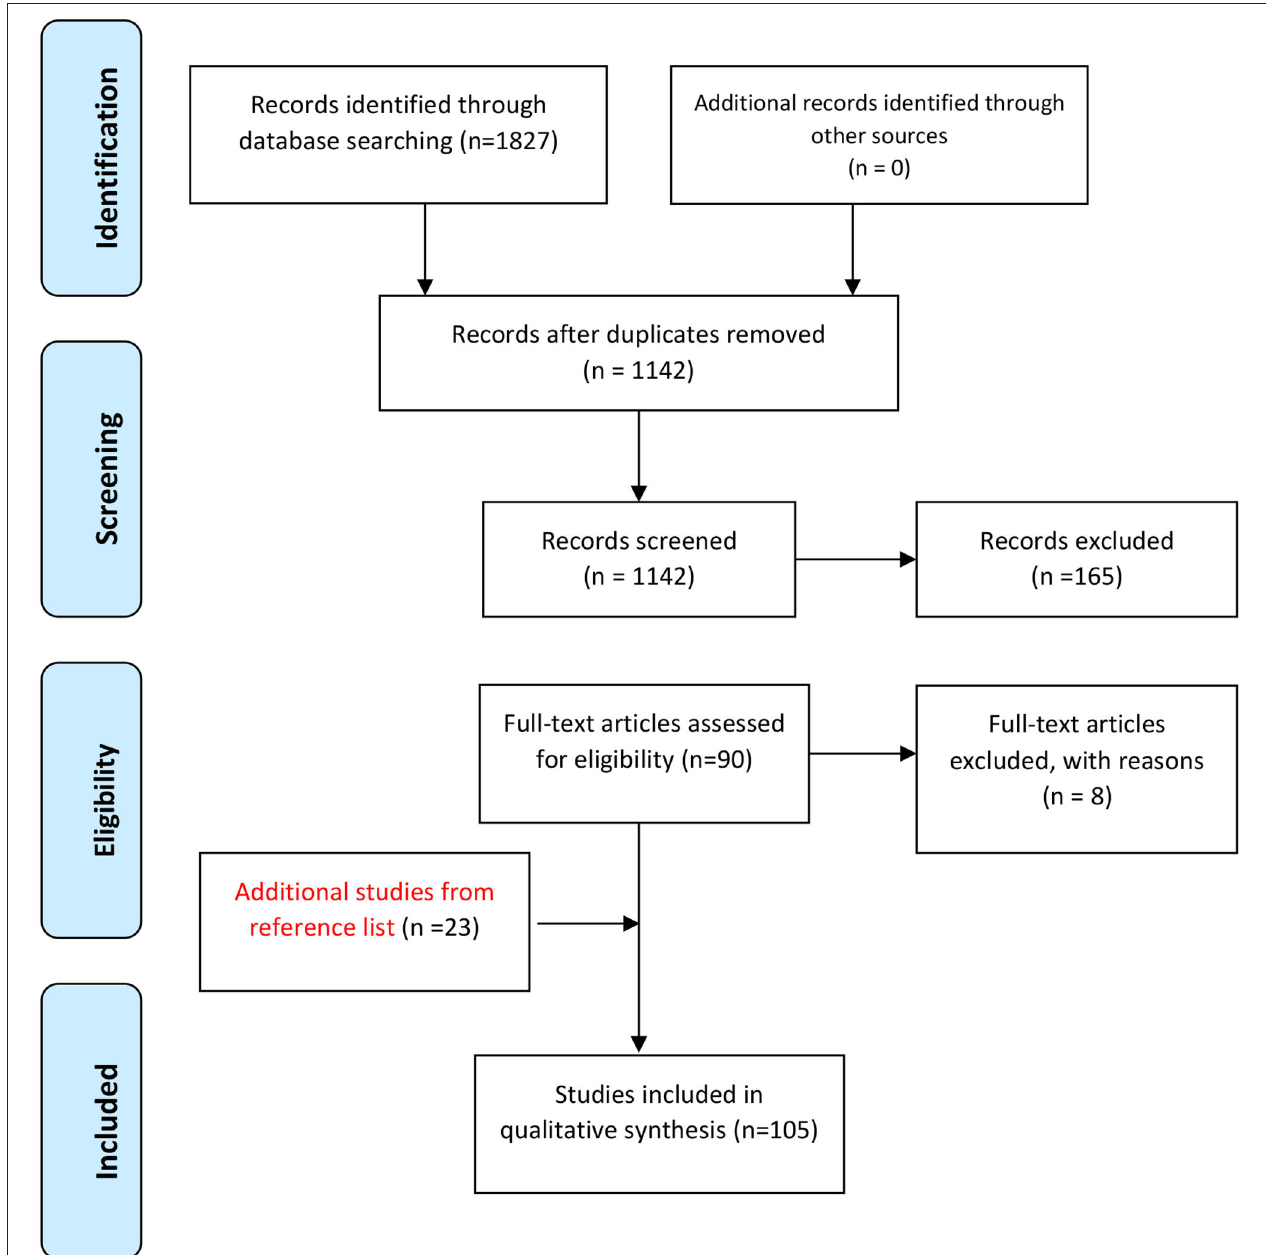
FIGURE 1 | PRISMA (Preferred Reporting Items for Systematic Reviews and Meta-Analyses) chart showing the process of systematic identification, screening, and selection of